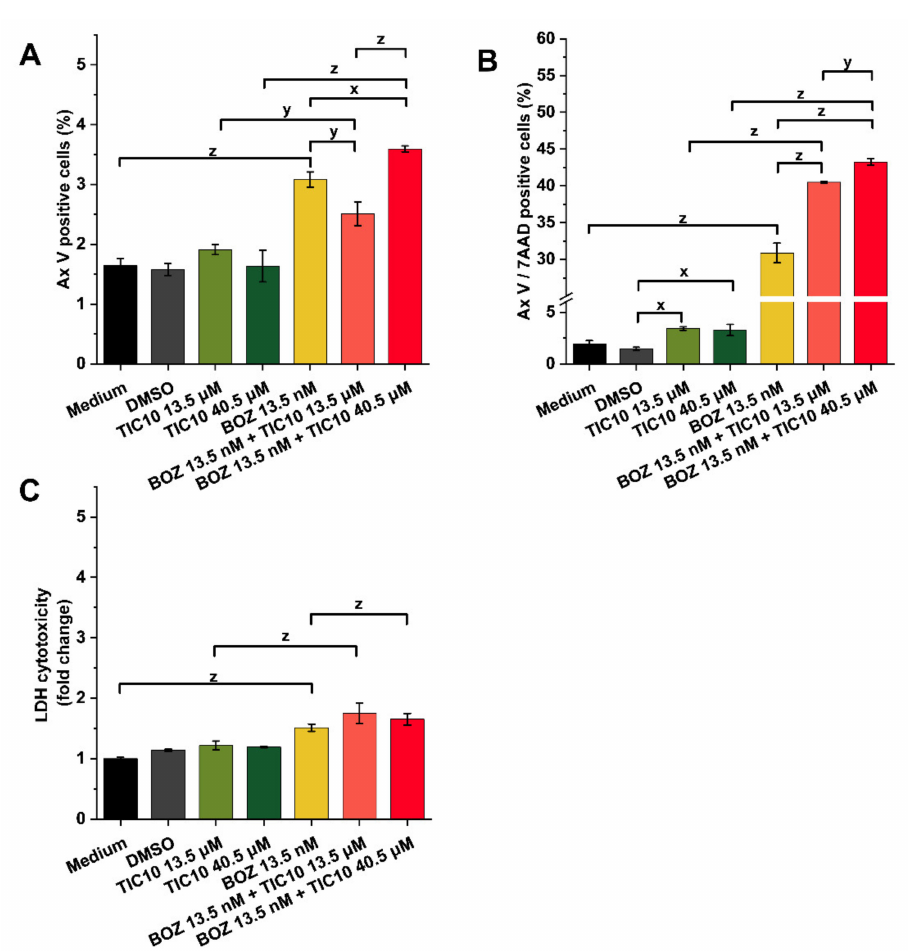
Figure 3. Analysis of the apoptotic and cytotoxic effects of the treatments. ( A ) Percentage of early apoptotic (Ax V-positive) and ( B ) late apoptotic (Ax V and 7AAD double-positive) cells, and ( C ) the fold change of the LDH release after 72 h treatment with bortezomib (BOZ), TIC10 and their combinations. ( C ) The data were normalized to the medium control. Data are presented as mean values ± standard deviation (SD) ( n = 3). The levels of significance are shown as follows: x: p < 0.05; y: p < 0.01; z: p < 0.001, determined by a one-way ANOVA test followed by Fisher’s LSD post hoc